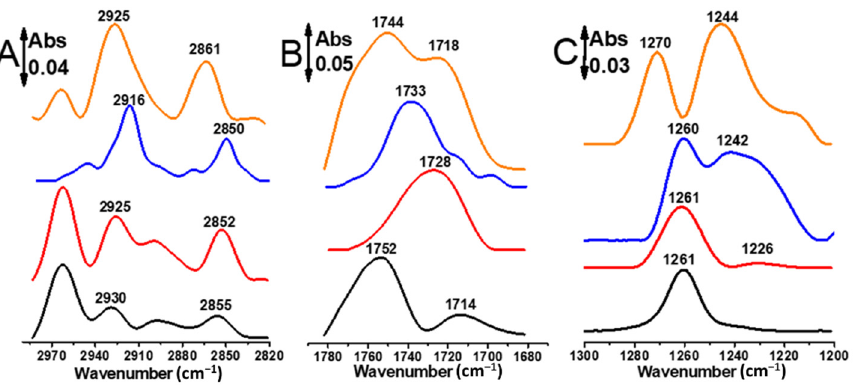
Figure 3. Absorbance FTIR spectra of the lipid DPPTE immobilized on silicon substrate (black lines), immobilized on gold nanoparticles (red lines), gold layer (blue lines) and on the Au nanoantennas (orange lines) measured at 25 ◦ C. ( A ) The spectra correspond to the ν s,as (CH 2 ), ( B ) ν (C=O) and ( C ) ν as (PO 2 − ) bands of the lipid.